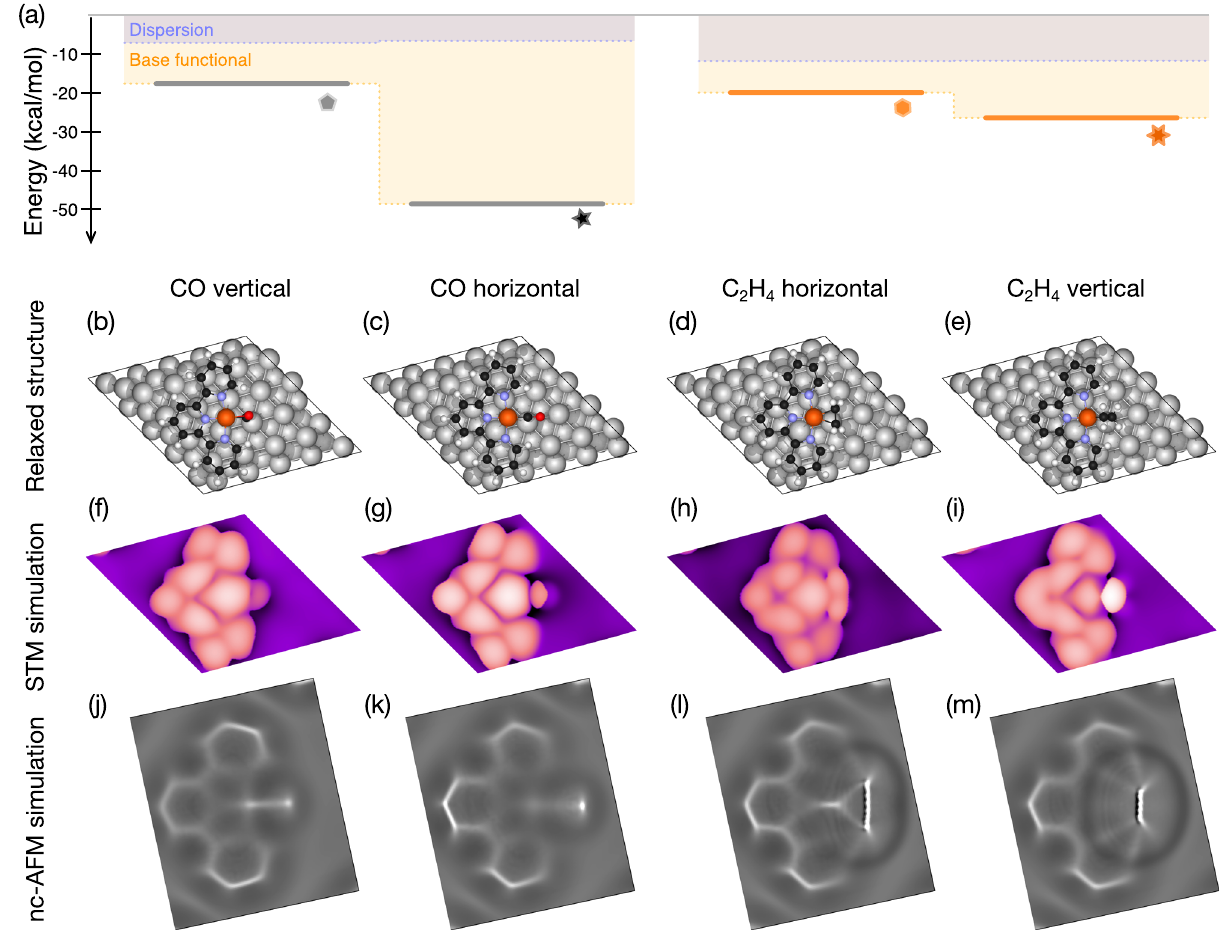
Fig. 6 |DFTmodelling of4 mostcommonlyobservedFe-tpyboundstructures. Dispersion corrected DFT simulation results for 4 most common stable structures showingbindingenergiesrelativetobareFe-tpyanddispersionandbasefunctional contributions for each ( a ) with optimized structure ( b – e ) and simulated STM ( f – i ) and Laplace fi ltered nc-AFM ( j – m ) shown below for each to compare with data. Comparing CO vertical and CO horizontal simulation results to Fig. 3, these most